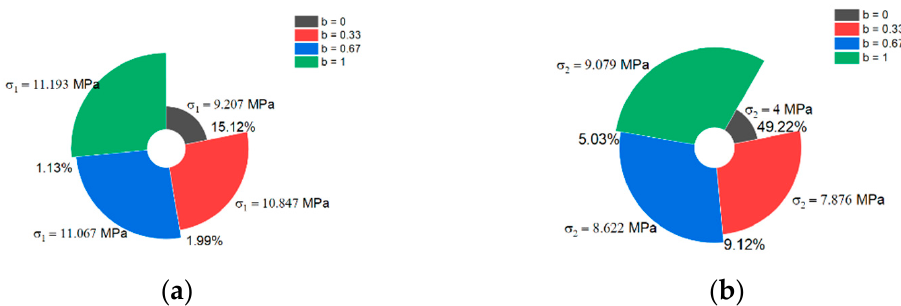
Figure 8. Distribution diagram of the influence of b value of middle principal stress coefficient: ( a ) σ 1